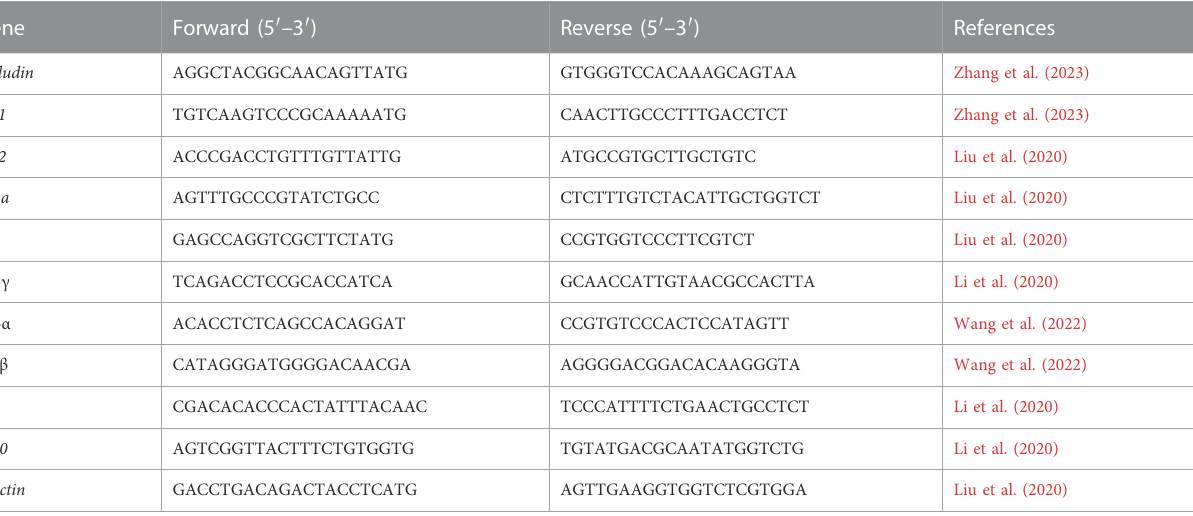
TABLE 2 Primers used for quantitative